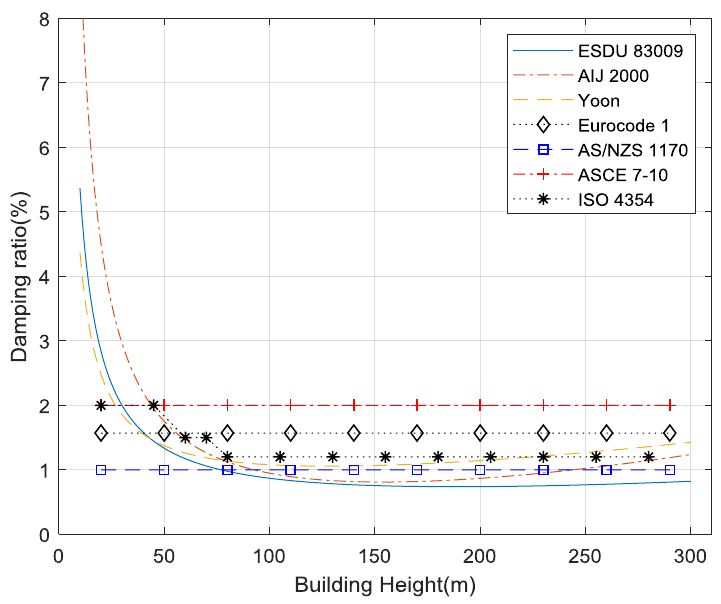
Figure 1. Values of structural damping ratio for RC buildings. Table 6. Structural damping ratios of RC buildings.